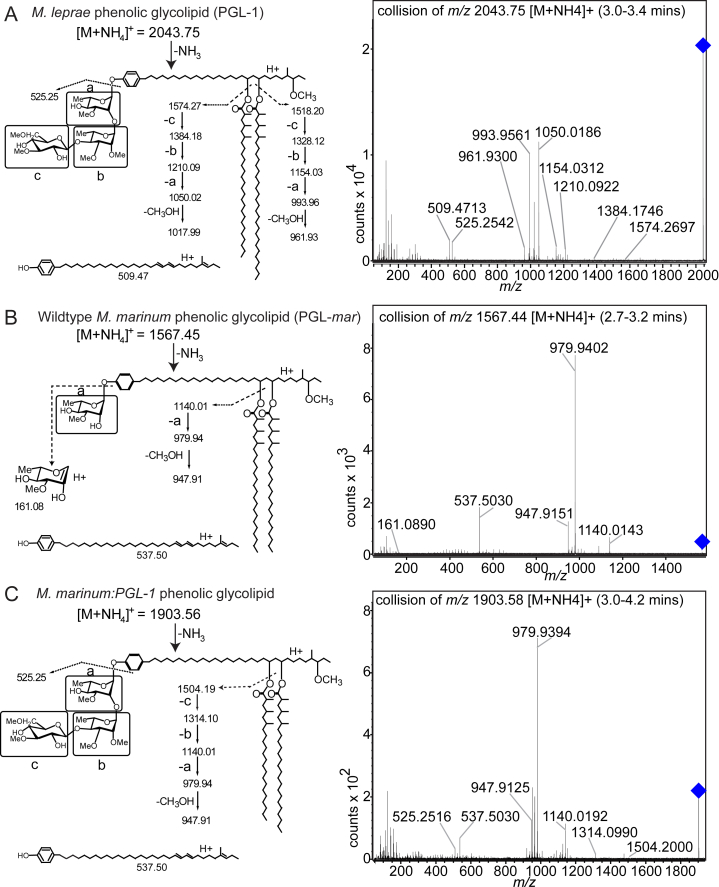
Collision-Induced Dissociation of Mycobacterial PGLs, Related to Figures 3A and 3B(A) Collision-induced dissociation of an ammoniated adduct of PGL-1 standard isolated from M. leprae shows calculated masses on the structure (left) with detected masses shown in the chromatogram (right). 30V collision energy; blue diamond = collided ion. Detected ions are assigned when they match the calculated masses within 10 parts per million (ppm), and the detailed substructures shown are consistent with known natural PGL components, but are not established directly. a, b and c correspond to the proximal, intermediate distal monosaccharides from M. leprae PGL-1.(B) Collision-induced dissociation of PGL-mar standard isolated from WT M. marinum, shown as in (A).(C) Collision-induced dissociation of PGL-1 from total lipid extract of an M. marinum:PGL-1 log phase culture, shown as in A. The fragments at m/z 525.25 detected in collision of PGL-1 from M. marinum:PGL-1 (C) and M. leprae (A), correspond to the known mass of PGL trisaccharides. In M. marinum:PGL-1 we detected PGL fragments corresponding to the loss of mycocerosic acid and monosaccharide c (m/z 1504.19) or the disaccharide cb (m/z 1314.10) or the trisaccharide cba (m/z 1140.01). These fragments provide a highly specific signature for the trisaccharide structure that is seen also in M. leprae PGL-1 fragments m/z 1574.27, m/z 1384.18 and m/z 1210.09 (A).